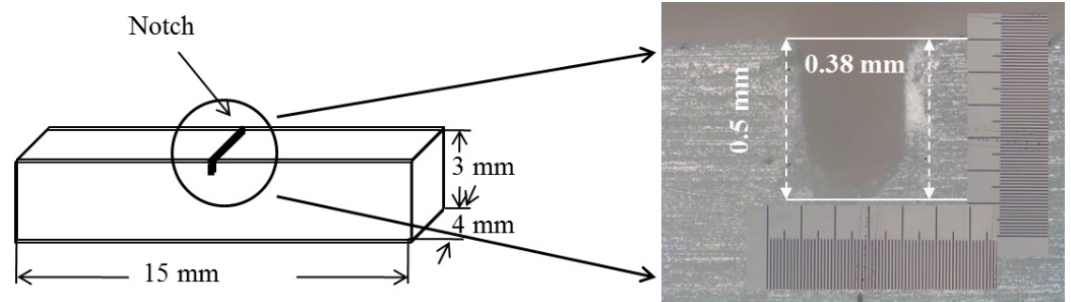
Figure 1. Shape and dimensions of the all-ceramic specimen, indicating the notch